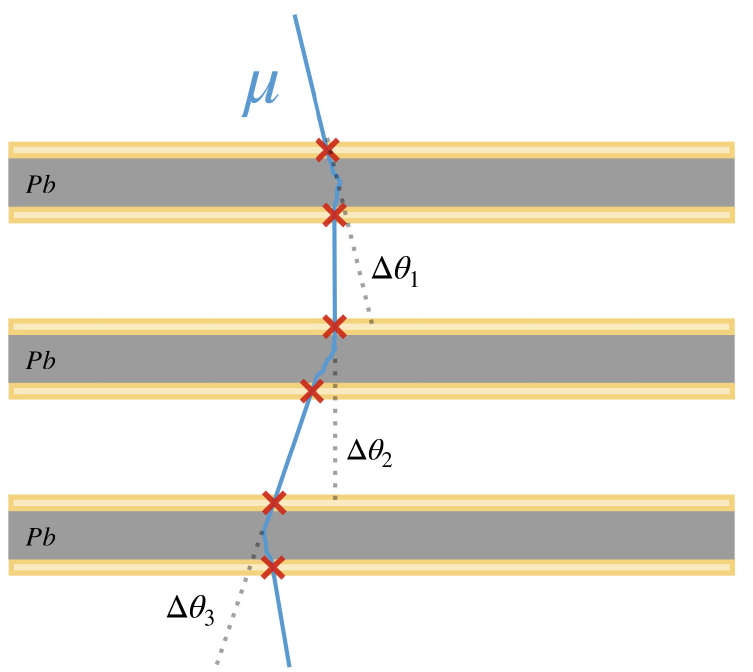
Figure 18. Multiple Coulomb scattering-based muon momentum sub-detector